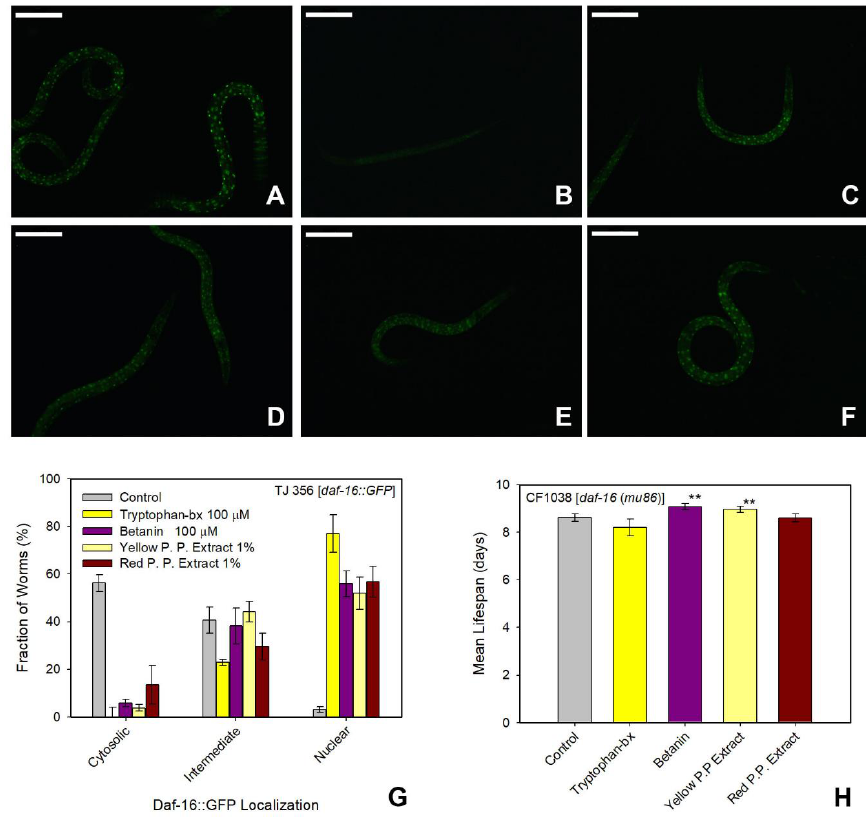
Figure 7. Effect of extracts and pure betalains on the longevity pathway. Representative fluorescence images from TJ356 [daf-16::GFP] strain, positive control ( A ), negative control, ( B ), treated with tryptophan-betaxanthin, ( C ), treated with betanin, ( D ), treated with yellow ( E ) and red ( F ) prickly pear extracts. Scale bar: 100 µm. ( G ) Histograms for the fraction of cytosolic, intermediate, and nuclear classification of worms of the TJ356 [daf-16::GFP] strain treated with tryptophan-betaxanthin ( n = 48), betanin ( n = 34), yellow ( n = 52), and red ( n = 44) prickly pear extracts and without treatment ( n = 32). Two independent trials were measured. ( H ) Mean lifespan (mean ± SE) of C. elegans [daf-16(mu86)] mutant animals (CF1038 strain) treated with tryptophan-betaxanthin ( n = 53), betanin ( n = 40), yellow ( n = 61), and red ( n = 58) prickly pear extracts and without treatment ( n = 62). ** indicated p ≤ 0.05.